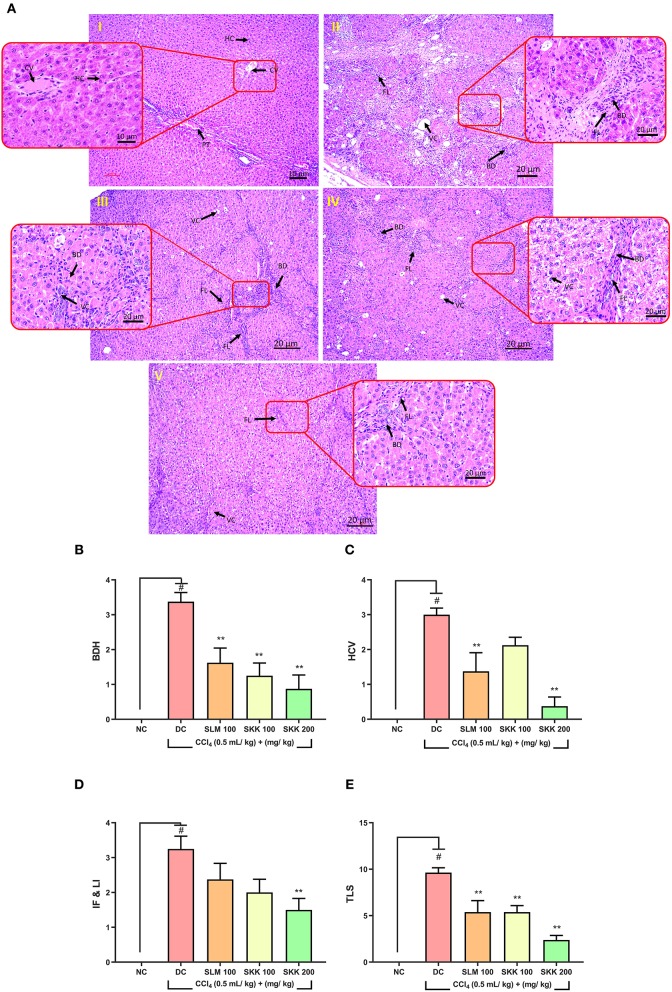
Histopathological Analysis of Wistar Rats Treated with CCl4 and Co-Treated with Divya Sarva-Kalp-Kwath (SKK): (A) Histopathological investigation was performed in the liver tissue samples obtained from the Wistar rats treated for 9 weeks with CCl4, reference drug: SLM (100 mg/kg) and SKK (100 and 200 mg/kg). Results indicated- (i) Untreated animal liver tissue represents normal histology of liver tissue; portal triad (PT), central vein (CV), hepatocyte, (ii) CCl4 treated animals showed the presence of severe fibrosis and lymphocytic infiltration (FL), hyperplastic bile duct in the hepatic regions, (iii) Wistar rats treated with SLM (100 mg/kg) showed the development of moderate fibrosis and lymphocytic infiltration (FL), hyperplastic bile duct (BD), vacuolation (VC) in the hepatic tissues; (iv) CCl4 and SKK (100 mg/kg) co-treated animals showed moderate levels of fibrosis and lymphocytic infiltration (FL), hyperplastic bile duct (BD), vacuolation (VC) in their hepatic region; (v) Wistar rats treated with CCl4 and higher dose of SKK (200 mg/kg) showed the presence of mild fibrosis and lymphocytic infiltration (FL), hyperplastic bile duct (BD) in their hepatic regions. Finally, based on individual lesion scoring, the CCl4 treated animals showed marked increase in- (B) hyperplastic bile duct (BDH), (C) Hepatocellular vacuolation (HCV), (D) interlobular fibrosis and lymphocytic infiltration (IF & LI), and (E) Total Lesion Score (TLS). The positive control drug, SLM (100 mg/kg) significantly ameliorated the hepatic injuries induced by CCl4 treatment. CCl4 stimulated animals co-treated with SKK at 100 and 200 mg/kg also showed significant amelioration in their hepatic lesion score. Results are expressed as Mean ± Standard Error of Means. One-way analysis of variance (ANOVA) followed by Dunnett's multiple comparison t-test was used to calculate the statistical difference. p-value #<0.01; **<0.01.